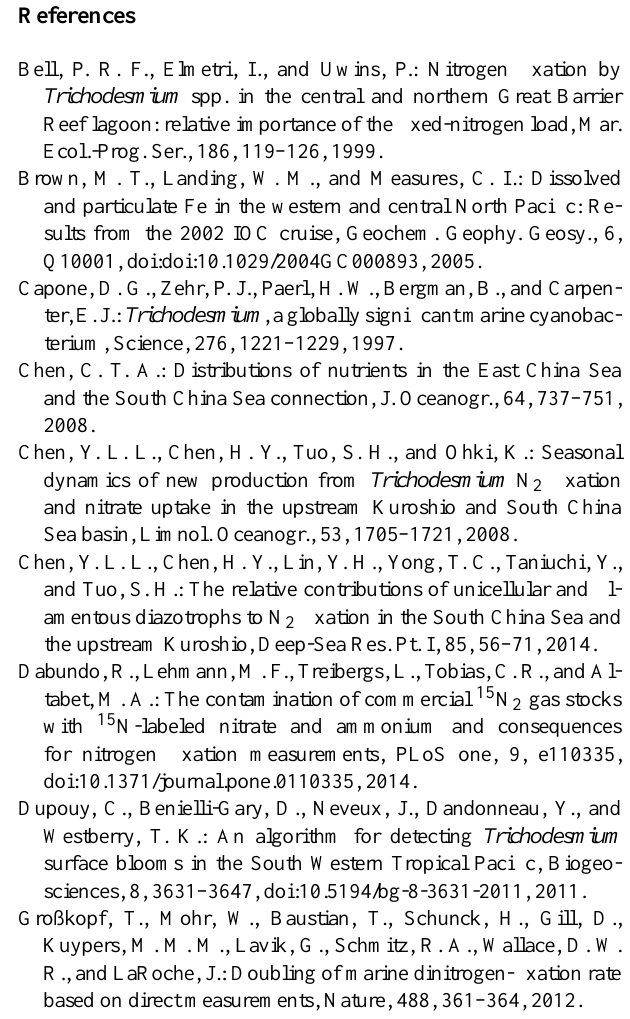
tabet, M. A.: The contamination of commercial 15 N 2 gas